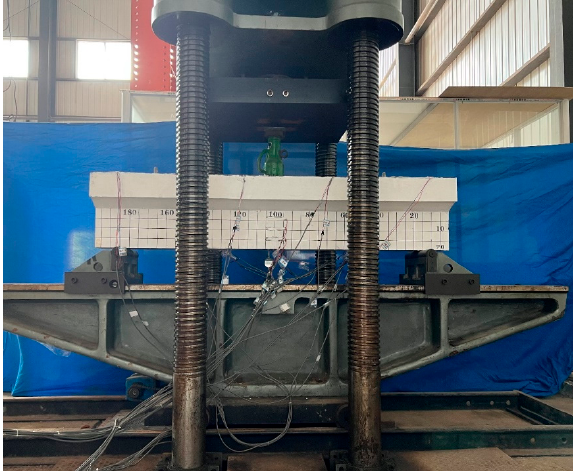
Figure 4. Loading test